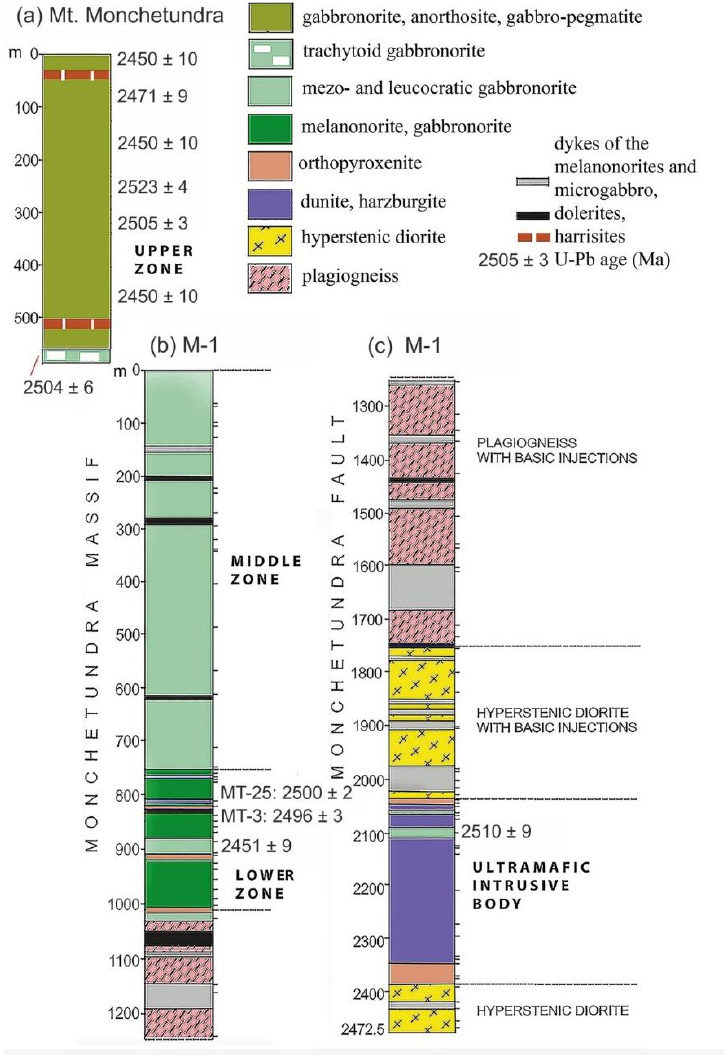
Figure 5. Schematic section of the Monchetundra massif ( a ) and M-1 structure borehole, 0–1250 m ( b ), 1250–2472.5 m ( c ), and U–Pb age (Ma) by data [10,13,17]. MT-25, MT-3—boreholes of the